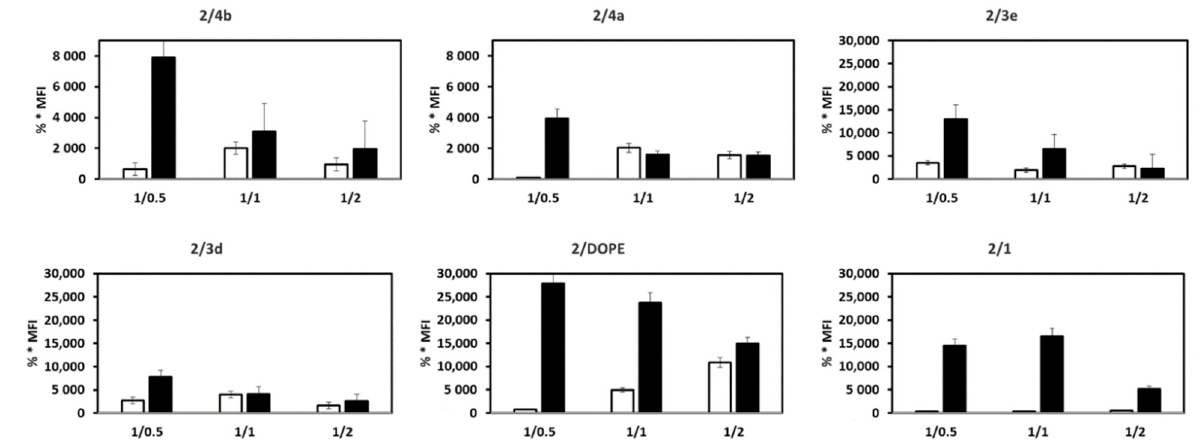
Figure 8. Comparison between the transfection efficiency of mRNA and DNA LXs. DC2.4 cells were transfected with 5 µ g of (black bar) mRNA-EGFP or (white bar) pEGFP complexed with the indicated liposomes at indicated mRNA/L or DNA/L ratio. In 3b / DOPE and 2 / DOPE LX, the lipid molar ratio was 2/1. % * MFI is the global transfection (i.e., the product of the number of EGFP positive cells by MFI). The final values are means ± SD of three different experiments.